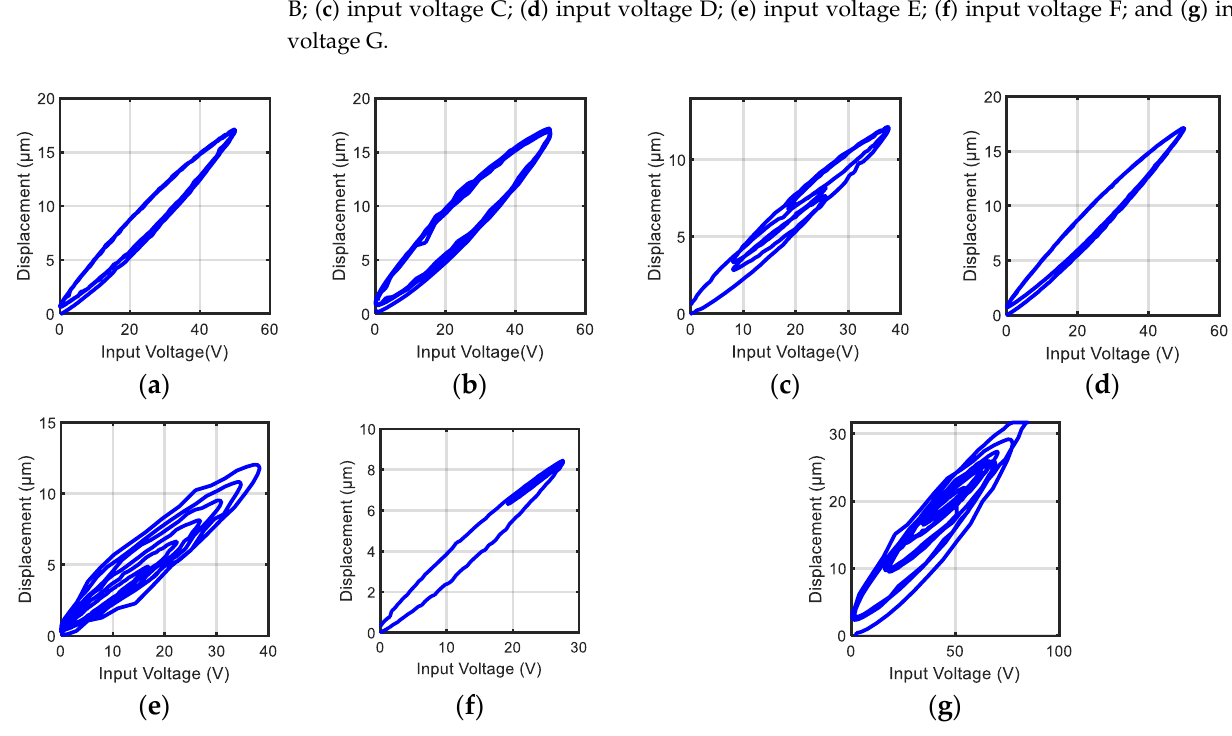
Figure 3. The corresponding input – output relationship obtained by: ( a ) reference input A; ( b ) refer- ence input B; ( c ) reference input C; ( d ) reference input D; ( e ) reference input E; ( f ) reference input F; and ( g ) reference input G.